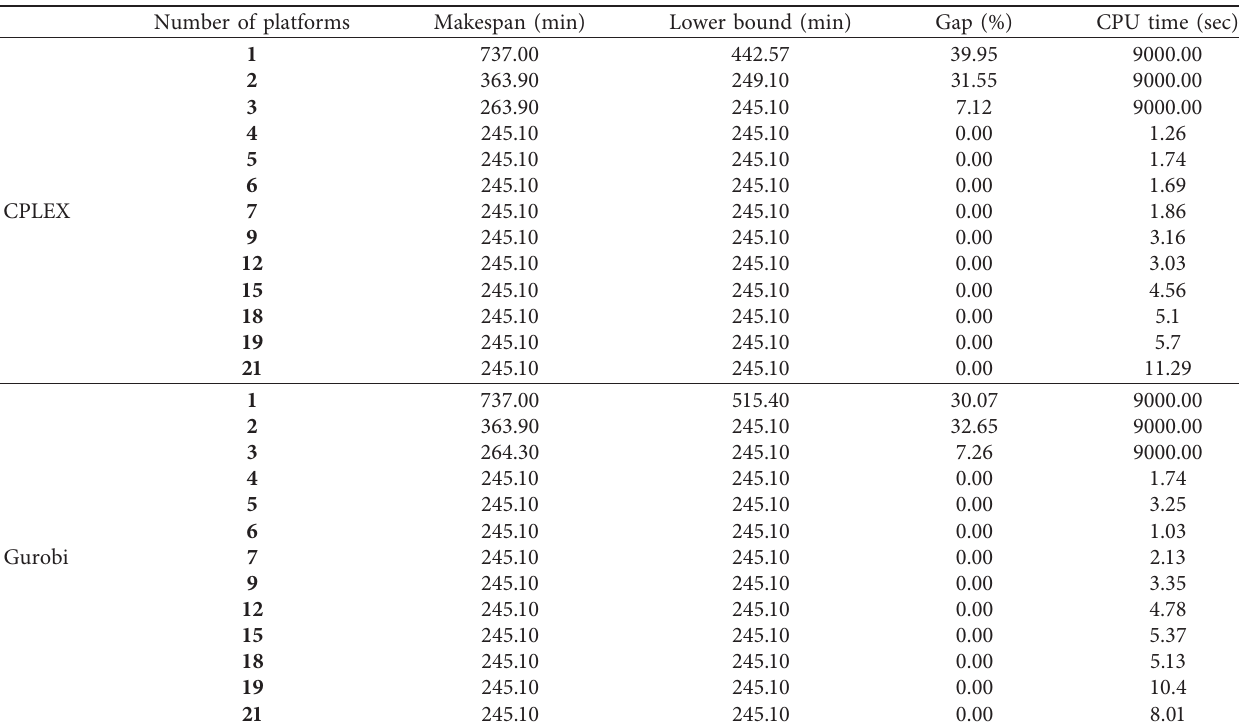
Table 4: Obtained results for the future scenario of ice cream in C